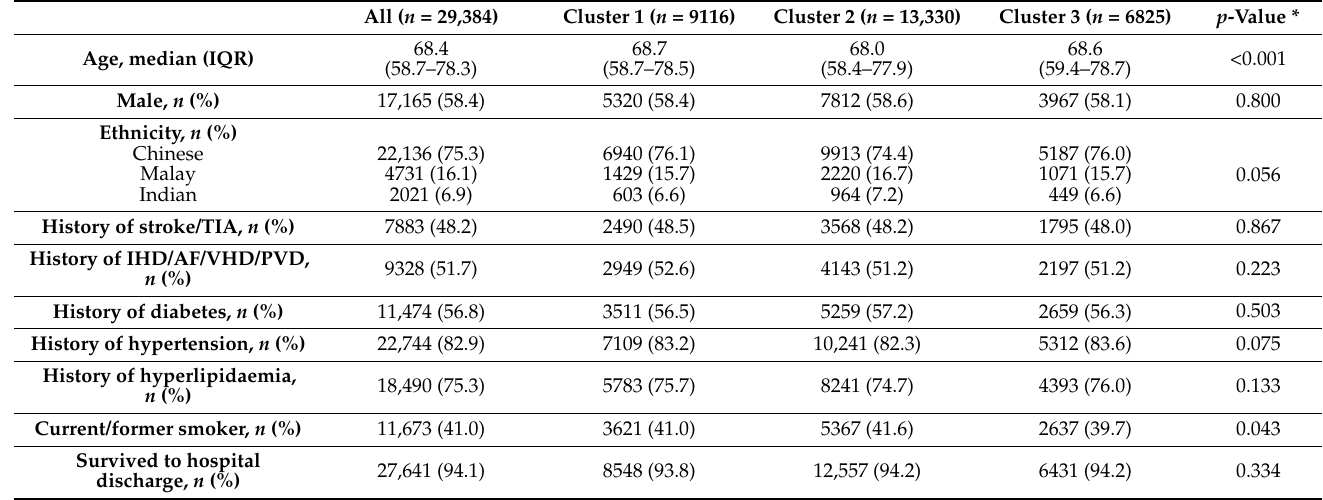
Table 1. AIS characteristics of the clusters ( n = 29,384 AIS